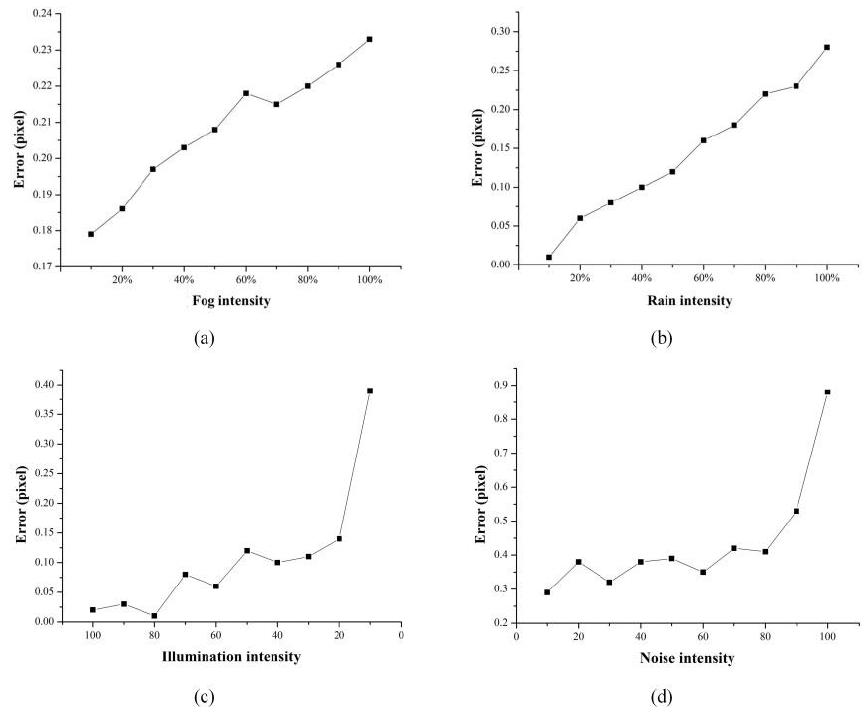
Figure 8. The influence of environment parameters on image center positioning results: ( a ) fog; ( b ) rain; ( c ) low illumination; ( d ) noise.